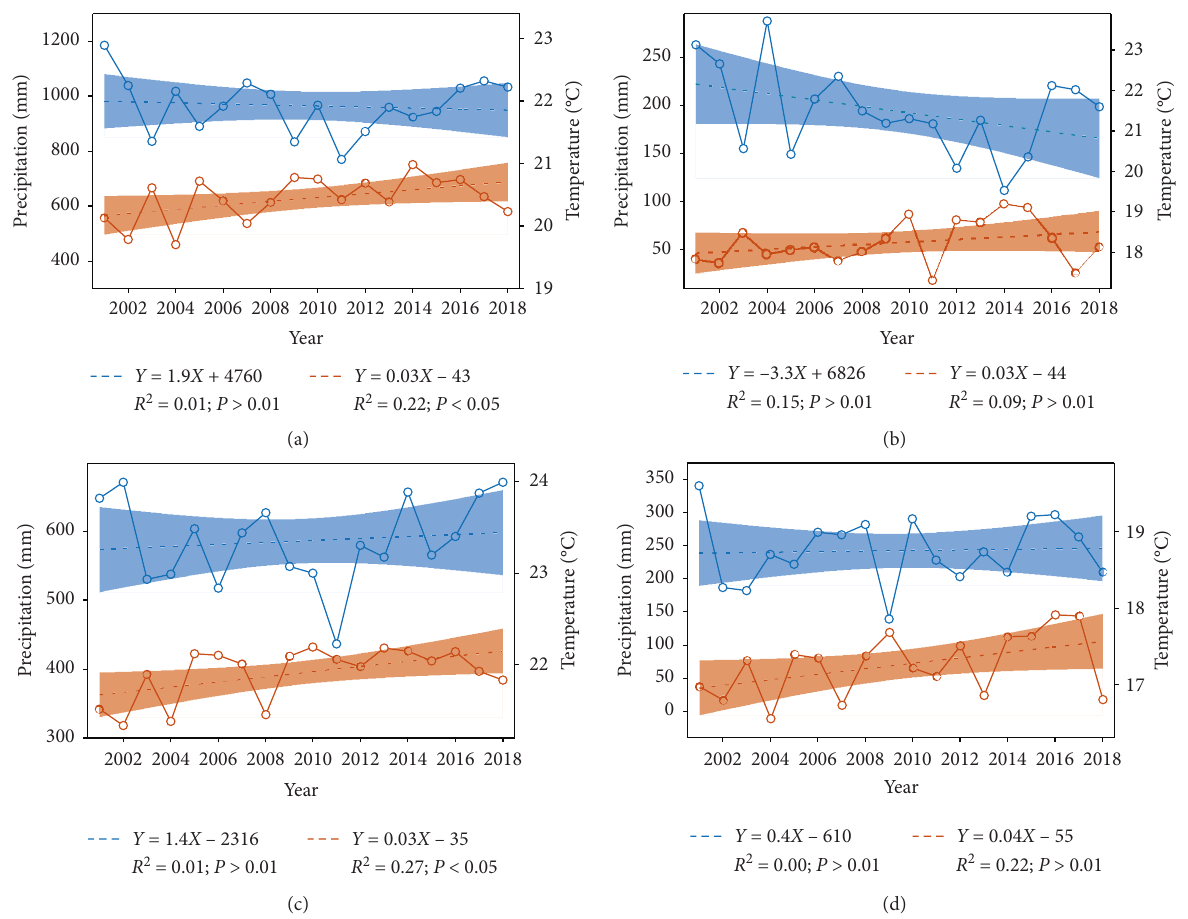
Figure 5: Interannual variation of precipitation and temperature. (a) Growing season; (b) spring; (c) summer; (d) autumn. The blue dotted line is the fitting line and the blue solid line is the variation line of the precipitation. The brown dotted line is the fitting line and the brown solid line is the variation line of the